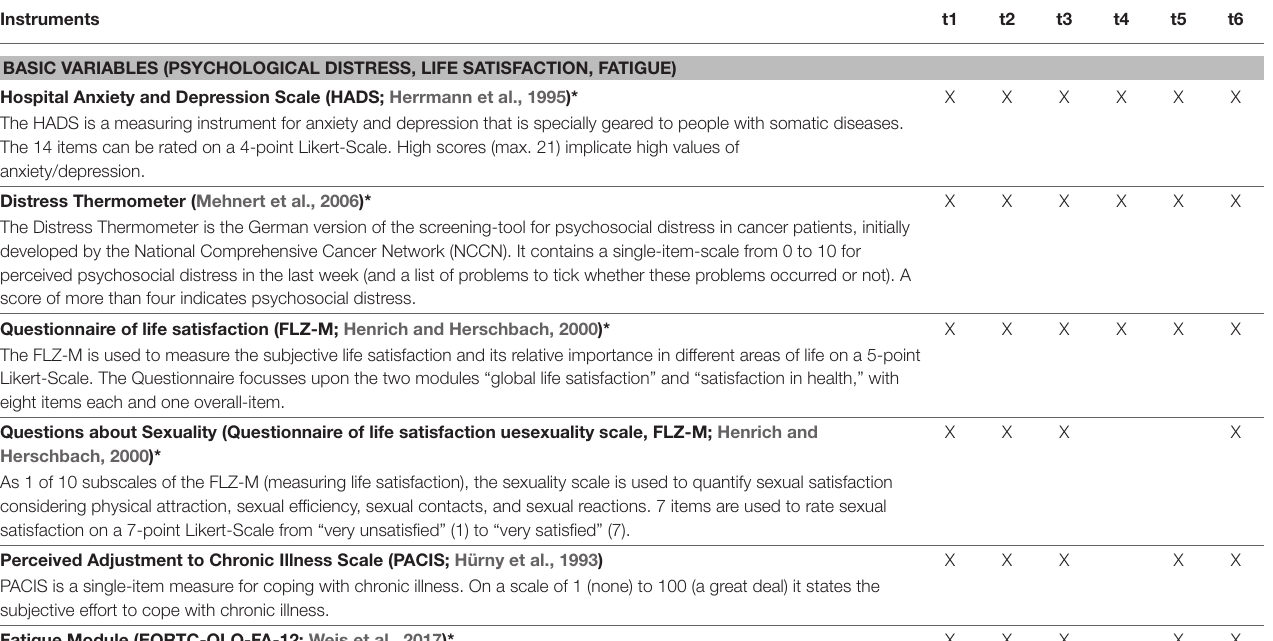
TABLE 1 | Overview of study instruments used from t1 to